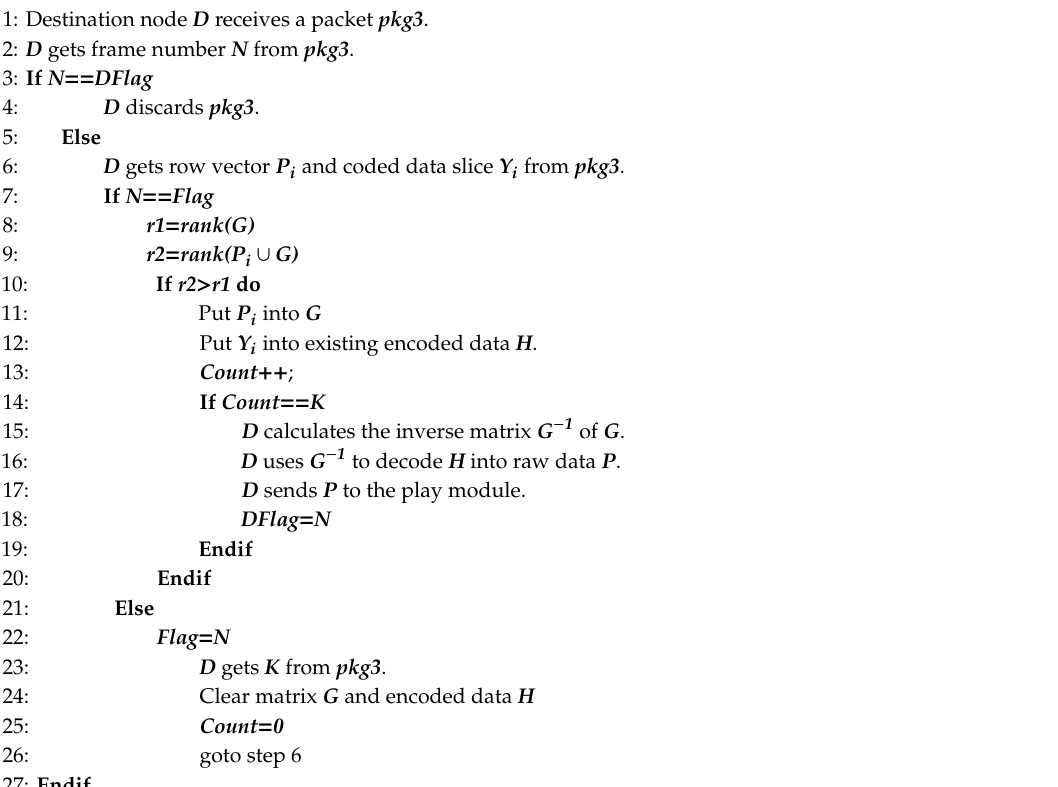
Algorithm 3 Decoding strategy at the destination